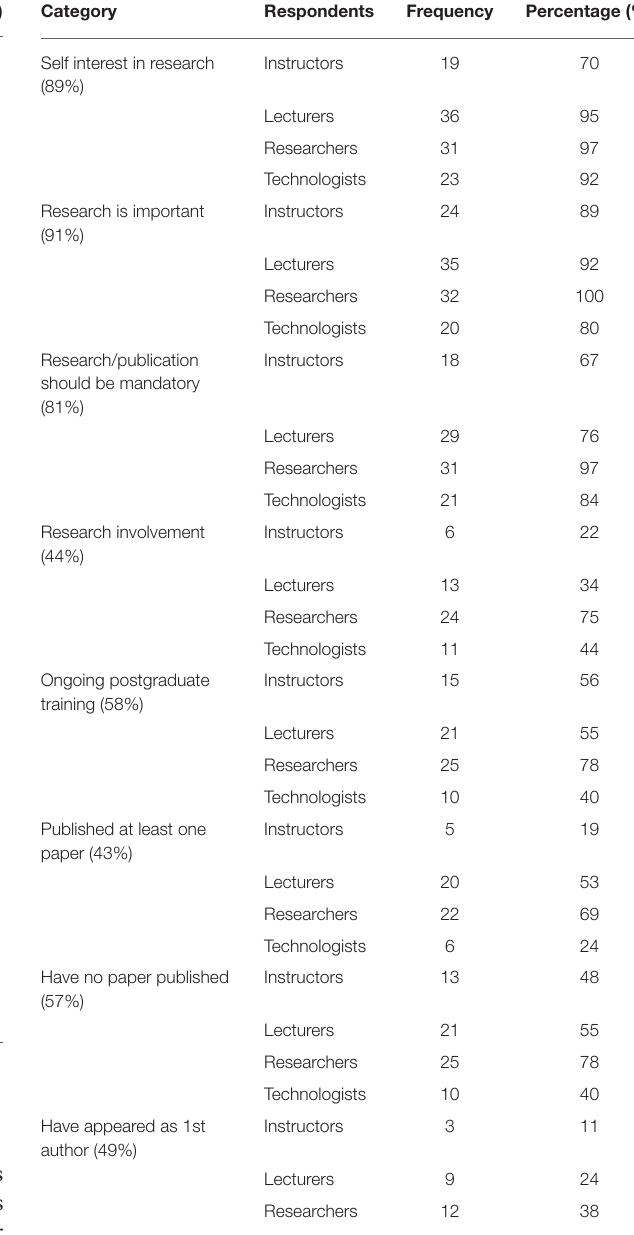
TABLE 3 | Attitudes and perceptions toward conducting research and publishing of articles that are specific among the different cadres of respondents.